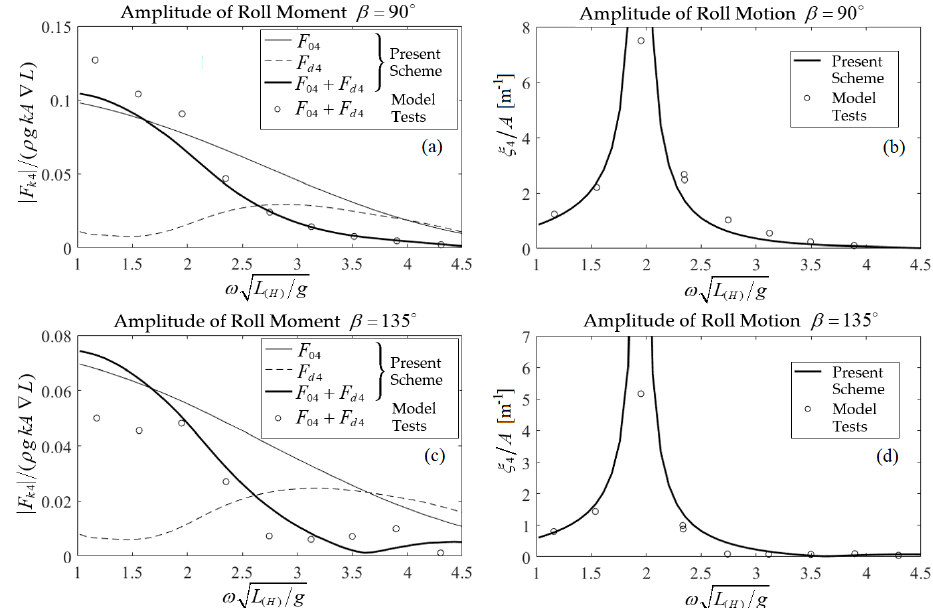
Figure 3. Normalized non dimensional roll moments ( a , c ) and roll motion responses ( b , d ), as functions of the non dimensional frequency, as calculated via the present method and as measured using model tests [21] for incident wave fields propagating at ( a , b ) β = 90 ◦ and ( c , d ) β = 135 ◦ . Froude– Krylov, diffraction and total roll moments, as calculated by the present BEM scheme, are plotted using thin, dashed and thick lines, respectively.